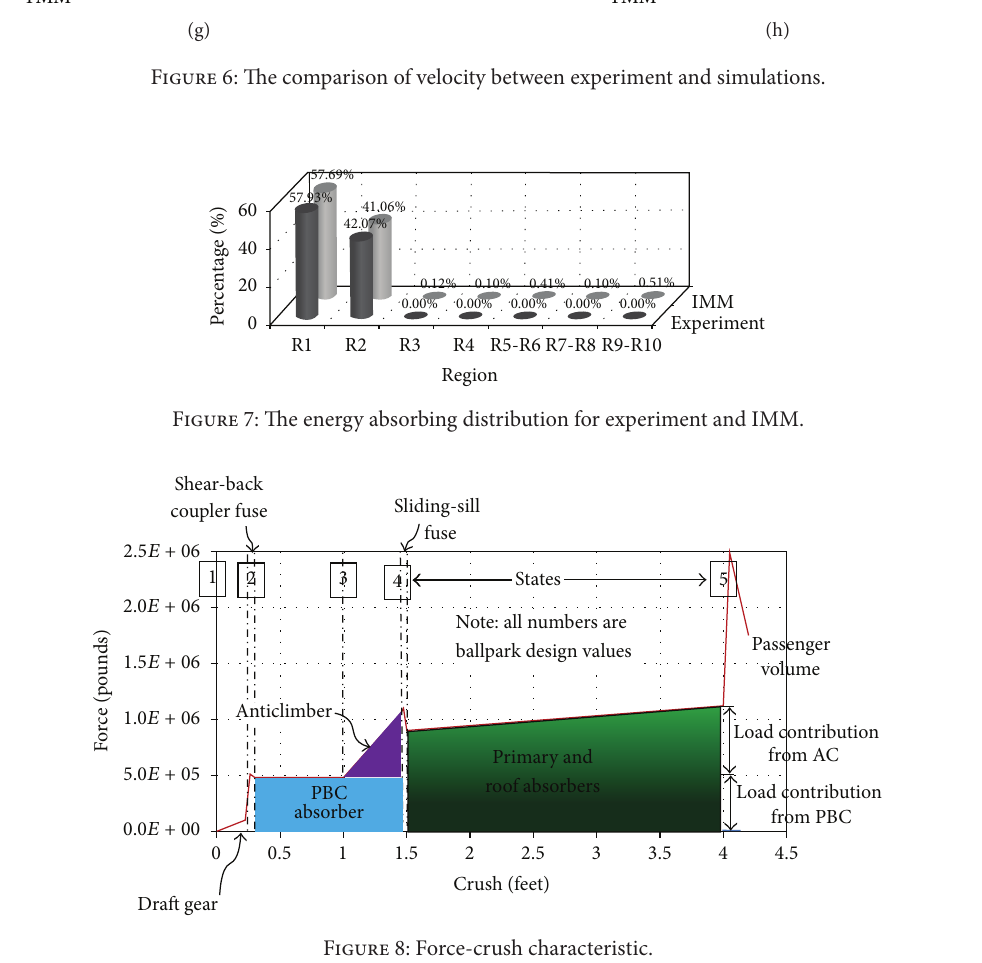
2 indicates that the energy is evenly distributed between two head cars; 𝑀 1 is head car mass; V is head car velocity; 𝐸 𝑖 is energy absorption of a middle car; 𝑅 3 is the absorbed kinetic energy ratio of first and second collision